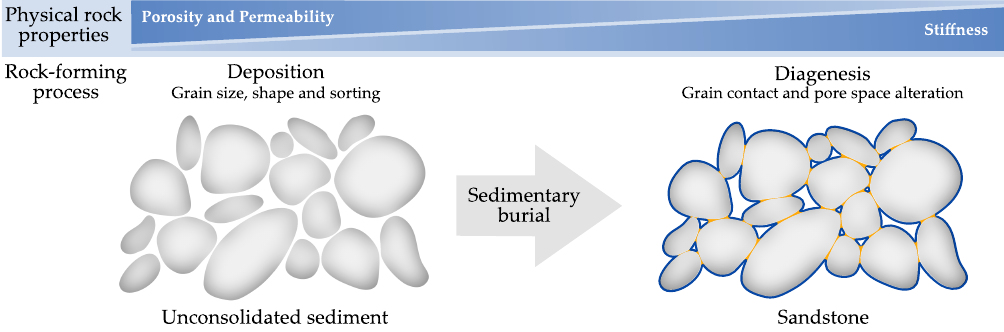
Figure 1. The microstructure of sandstones reflects the rock-forming processes involved in sediment deposition and diagenesis. While transport and deposition determine size, shape and sorting of the grains, diagenetic processes successively consolidate the sediment and alter its microstructure, e.g., by quartz overgrowth (blue) or grain contact cementation